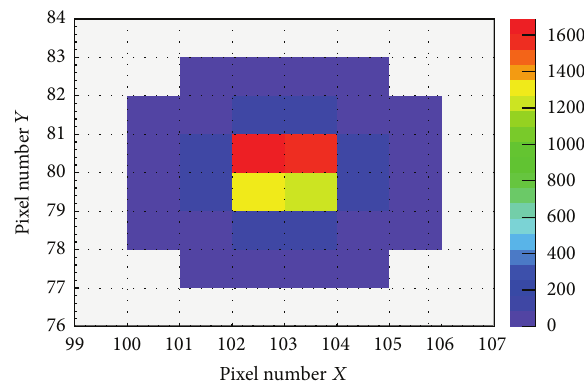
Figure 17: Expected sensitivity to the effective Majorana neutrino mass 𝑚 𝛽𝛽 fortheoptimalconfiguration(3 mmthicknessand 165 𝜇 m pixel pitch) as a function of the specific single-electron background rate 𝑏 before track analysis given in counts/(kg × keV × yr).